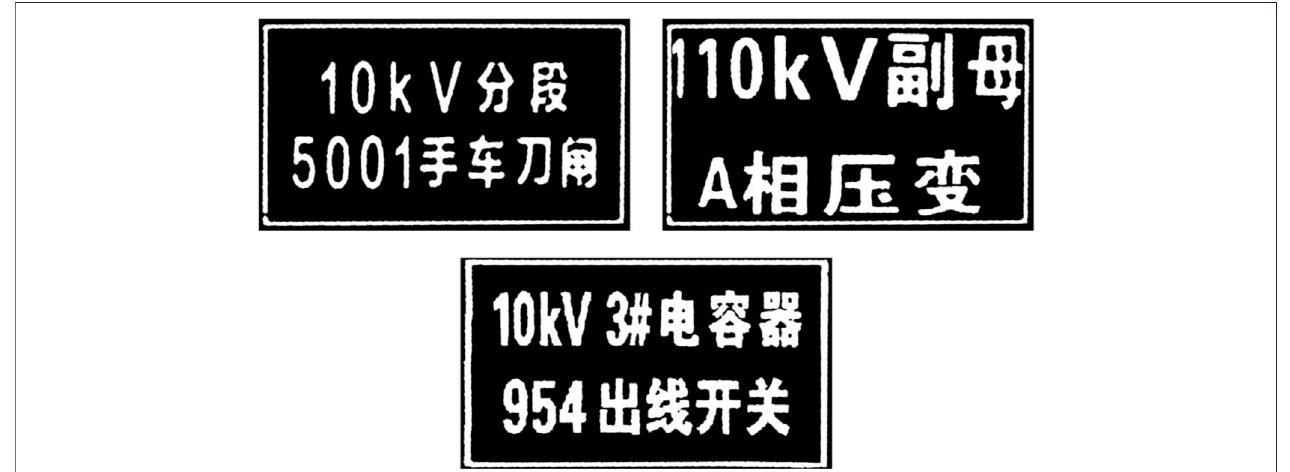
FIGURE 3 | Training samples.